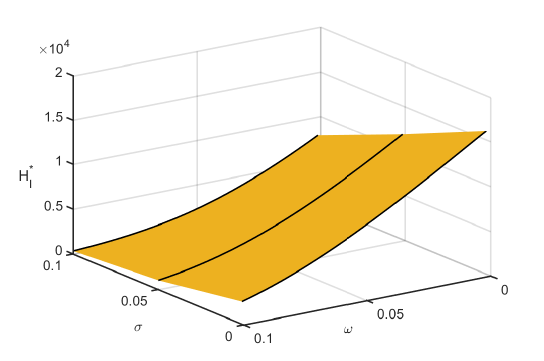
Figure 7. Combined effects of local and global awareness on infected population.